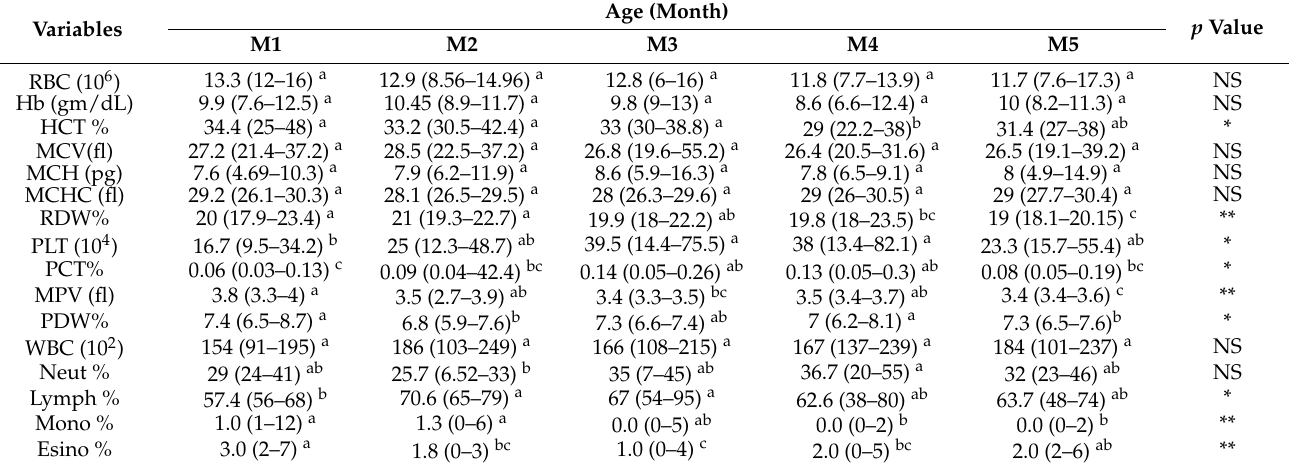
Table 5. Hematological profile during the first five months of life in male Shiba